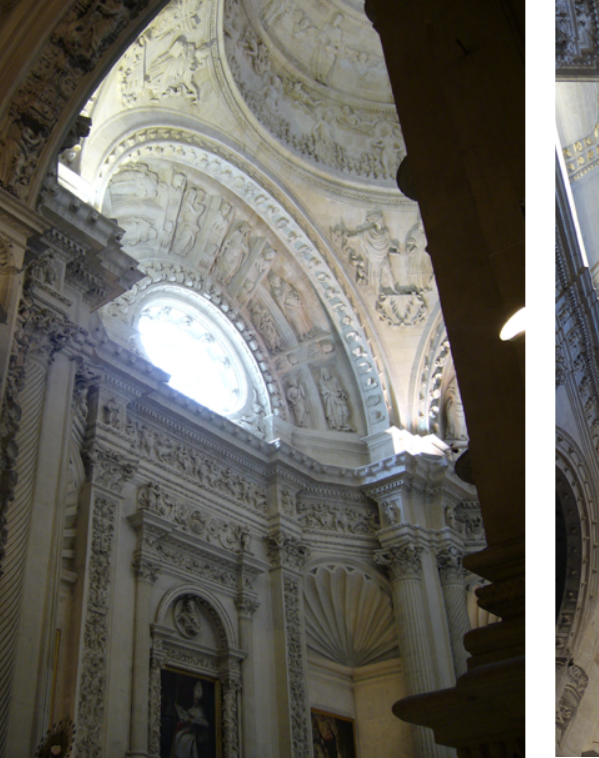
Figure 3: Interior of the sacristy, Seville Cathedral. Image by author.